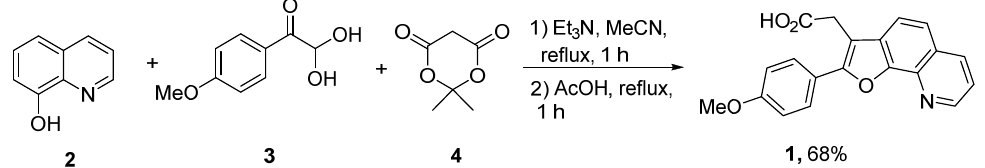
Scheme 1. Synthesis of 2-(2-(4-methoxyphenyl)furo[3,2- h ]quinolin-3-yl)acetic acid 1 . The assumed reaction pathway for the formation of 2-(2-(4-methoxyphenyl)furo quinolin-3-yl)acetic acid 1 is depicted in Scheme 2. Initially, base-catalyzed condensa- tion of arylglyoxal 2 with Meldrum’s acid 3 leads to unstable aroylmethylene derivative A . Next, the addition of 8-hydroxyquinoline anion B to intermediate A results in the for- mation of adduct D . Further acid treatment of intermediate D leads to the cleavage of Meldrum’s acid moiety accompanied by the liberation of acetone and CO 2 molecules. As a result, unstable γ -ketoacid F was formed. Finally, the cyclization of intermediate F with the elimination of water molecules leads to the target furylacetic acid 1 .